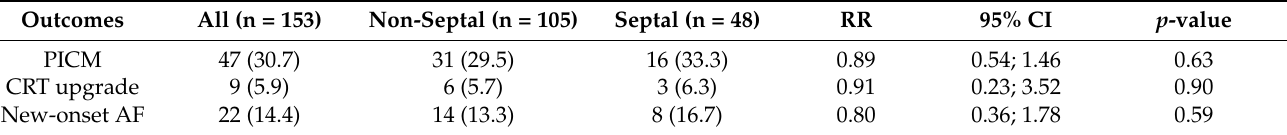
Table 2. Comparison of outcomes in patients with RV non-septal and RV septal lead